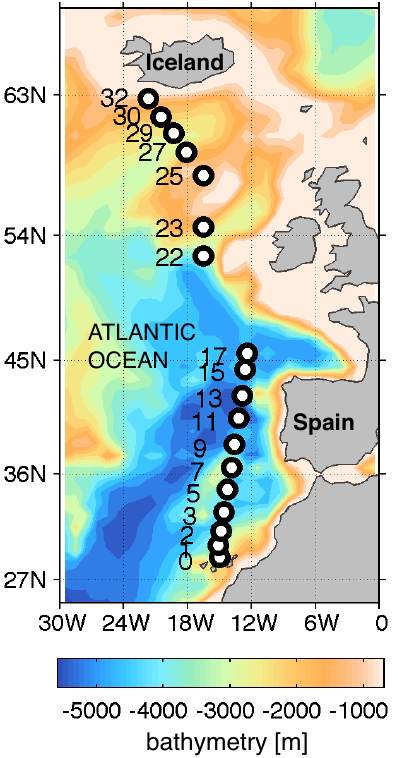
Fig. 1. Map with the location of the CTD stations where SCAMP measurements were performed during the STRATIPHYT-II cruise (6 April–3 May 2011). The details of each depicted station are pre- sented in the accompanying Table 1.